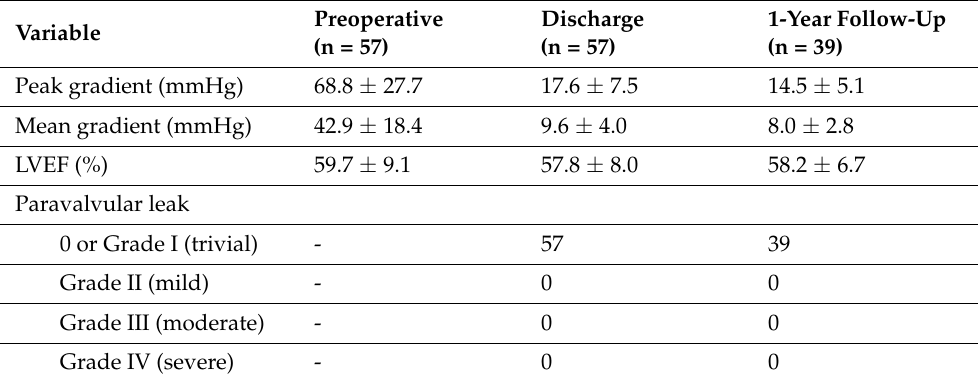
Table 4. Echocardiographic